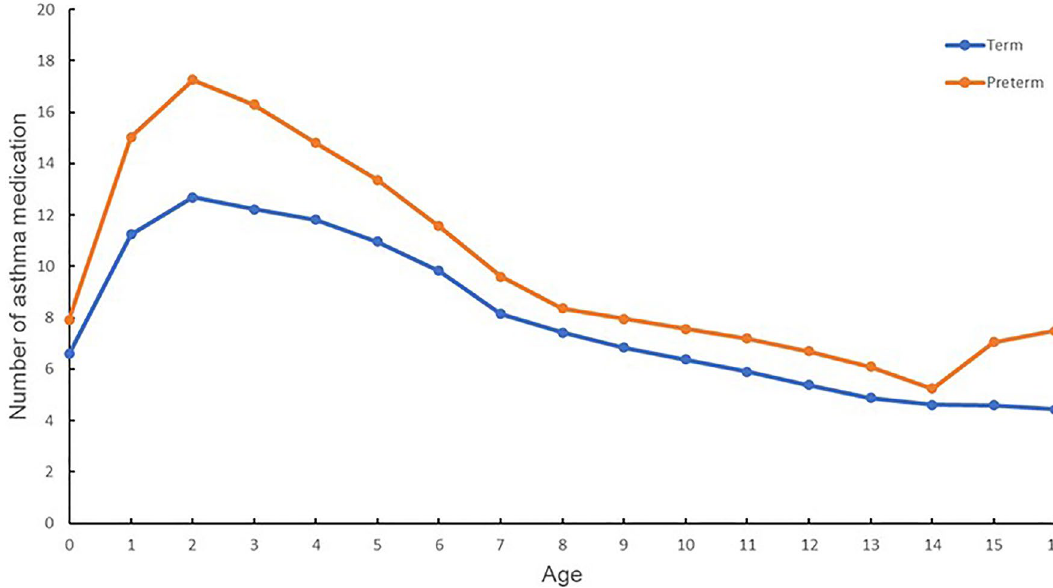
Figure 3. Number of asthma-related medications prescribed per patient stratified by age. An orange line depicts the number of asthma-related medications prescribed to preterm infants, stratified by age. A blue line represents the number of asthma-related medications prescribed to term infants, stratified by age.